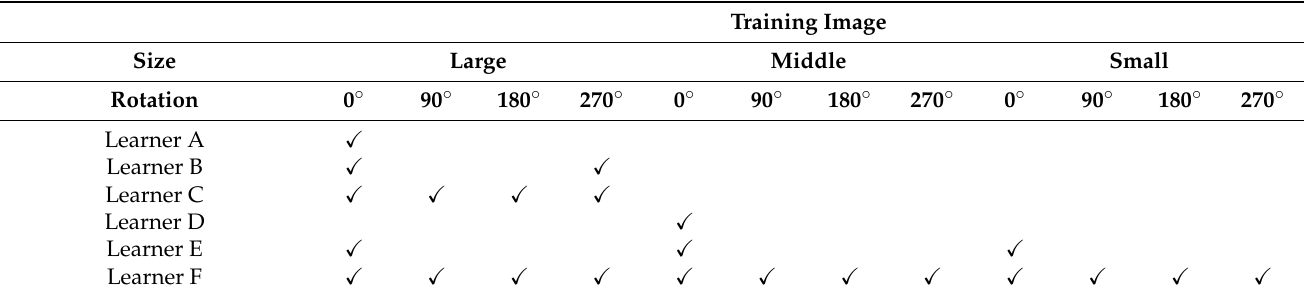
Table 1. List of the created